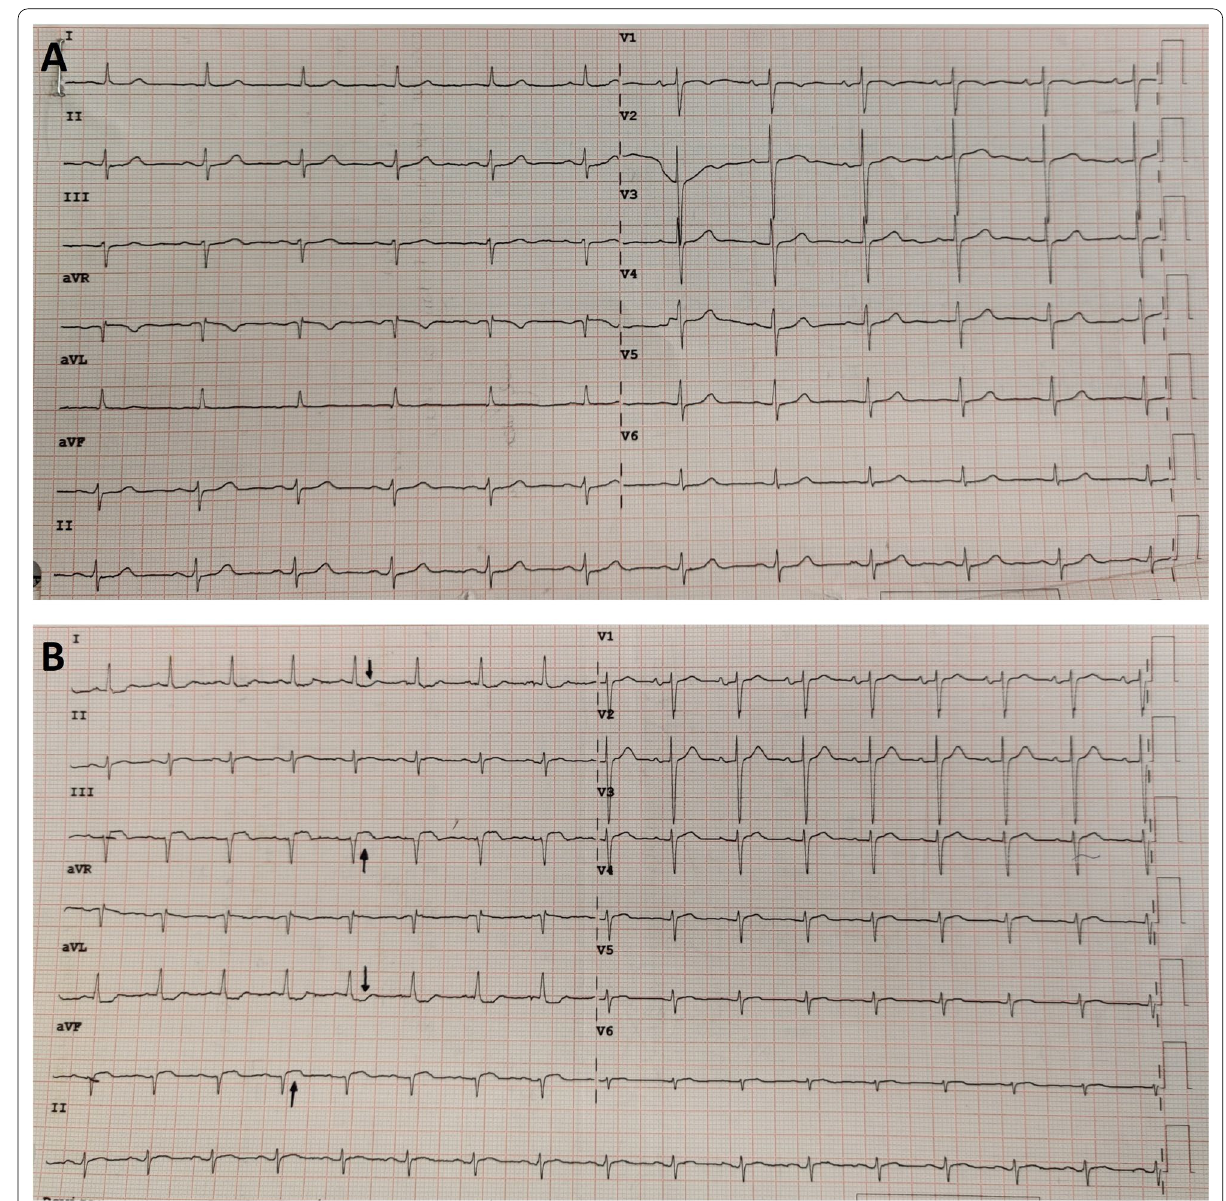
Fig. 6 Comparison of 12-lead ECGs taken during the patient’s first presentation ( A ) and last presentation ( B ) to hospital revealing new-onset ST elevations in inferior leads (III and aVF) with Q waves and ST depressions in leads I and aVL (marked with arrows). Paper speed 25 mm/s; voltage 10